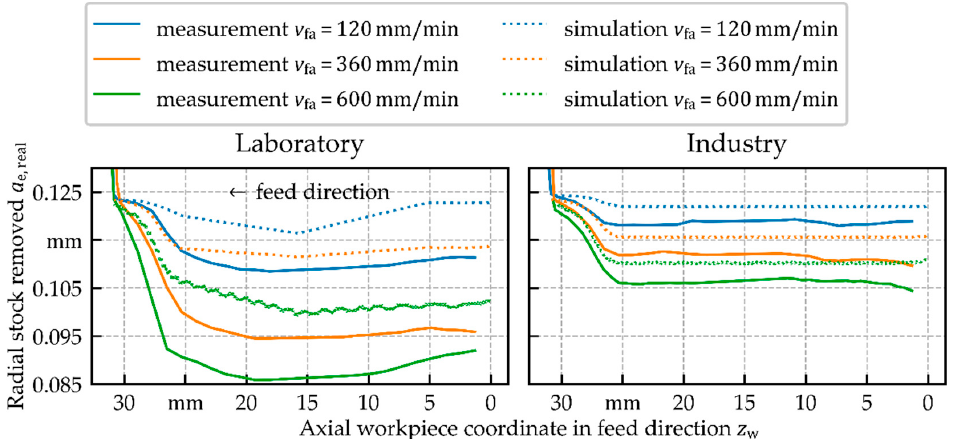
Figure 15. Comparison of measured and simulated workpiece contours after internal traverse grinding for lab and industrial environment.